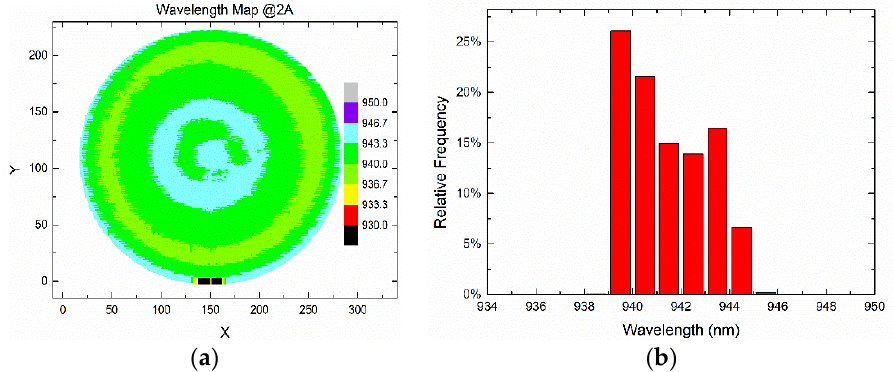
Figure 10. Performance of VCSEL devices over the 6-inch wafer measured by probing station made by Chroma (model) at 2A: ( a ) wavelength distribution map, ( b ) frequency statistics of wavelength.